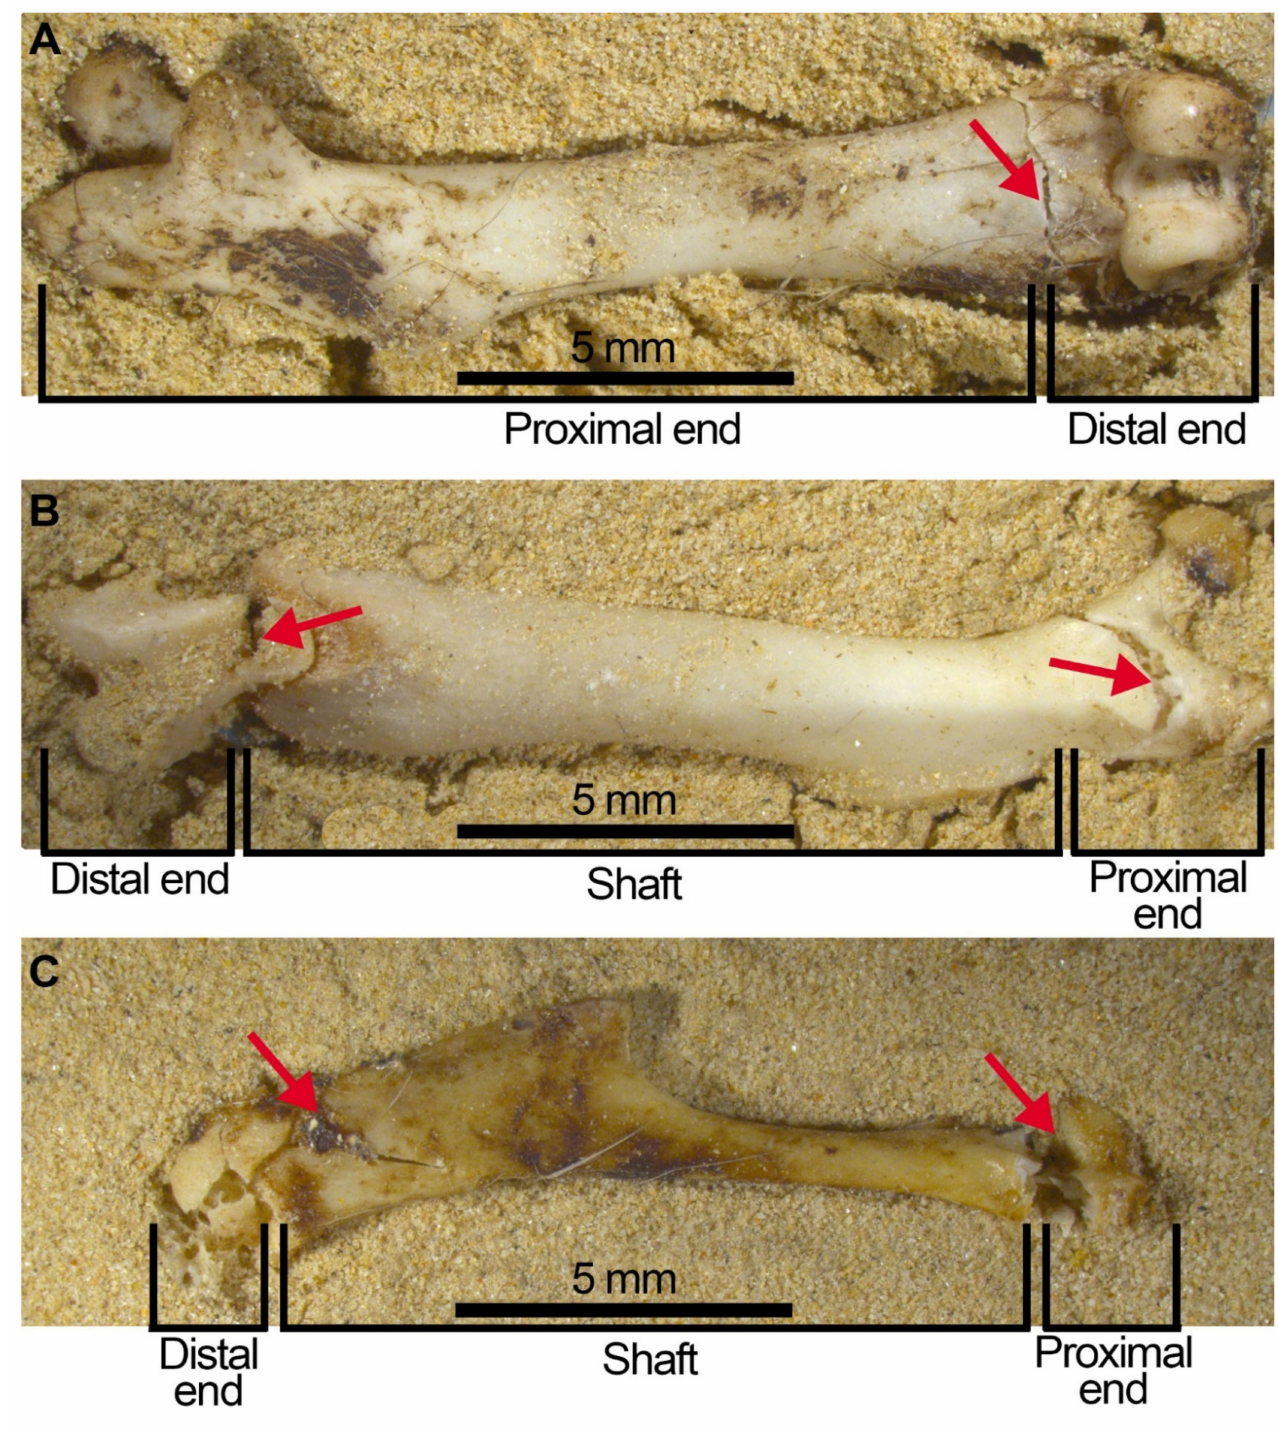
Figure 9. Fissures and open cracks that still join together and constitute complete bones. ( A ) complete femur circumference category 3 (cid:13) with a TRJ fissure on the distal end resulting in the proximal end + epiphysis segment being apart from the distal end in the compressed and processed sample. ( B ) the unfused distal end was detached from the femur’s articular end during the compression experiment. The femur remains as a complete element, despite the open crack (category 3 (cid:13) TRJ) shown on the proximal end which will easily cause detachment of the proximal end as well as the distal end from the diaphysis. ( C ) humerus with the distal end broken leaving the proximal end and diaphysis together, although the oblique fissure on the proximal end will cause breakage of the bone into three parts: Proximal end, shaft (almost complete) and distal